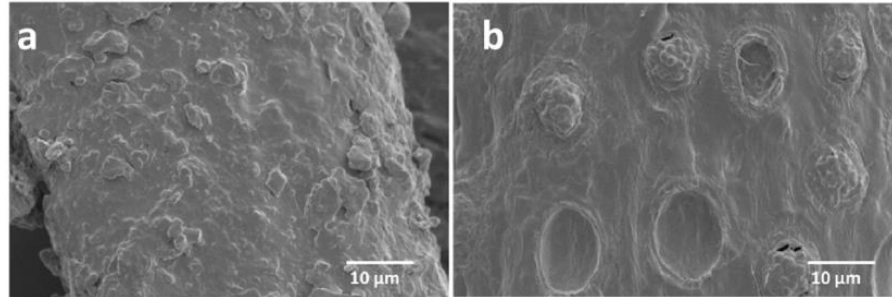
Figure 2. Scanning Electron Microscopy (SEM) of: ( a ) raw oil palm mesocarp fibres (OPMF), and ( b ) alkaline treated OPMF [6].